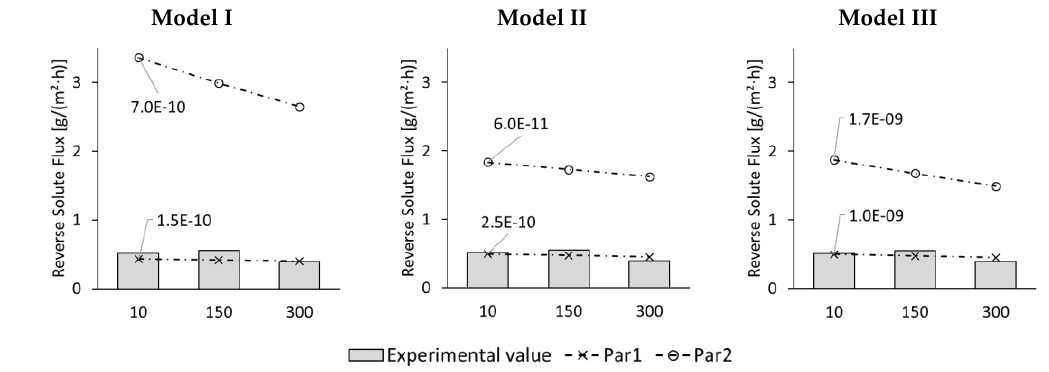
Figure 9. ALDS reverse solute flux of test series A5 for 10. 150, and 300 min test time from experiments (columns) and Model I, Model II, and Model III with membrane parameter set Par1 (dashed line with crosses) and Par2 (dashed line with circles). Modelled results are shown for best-fitting diffusion coefficient which is indicated next to the corresponding line.